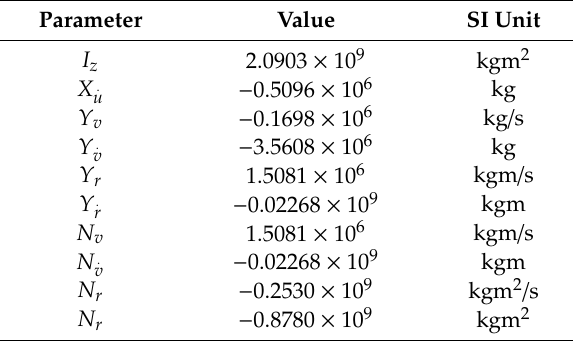
Table 3. Modeling parameters of environmental disturbances (wind, wave, and current).